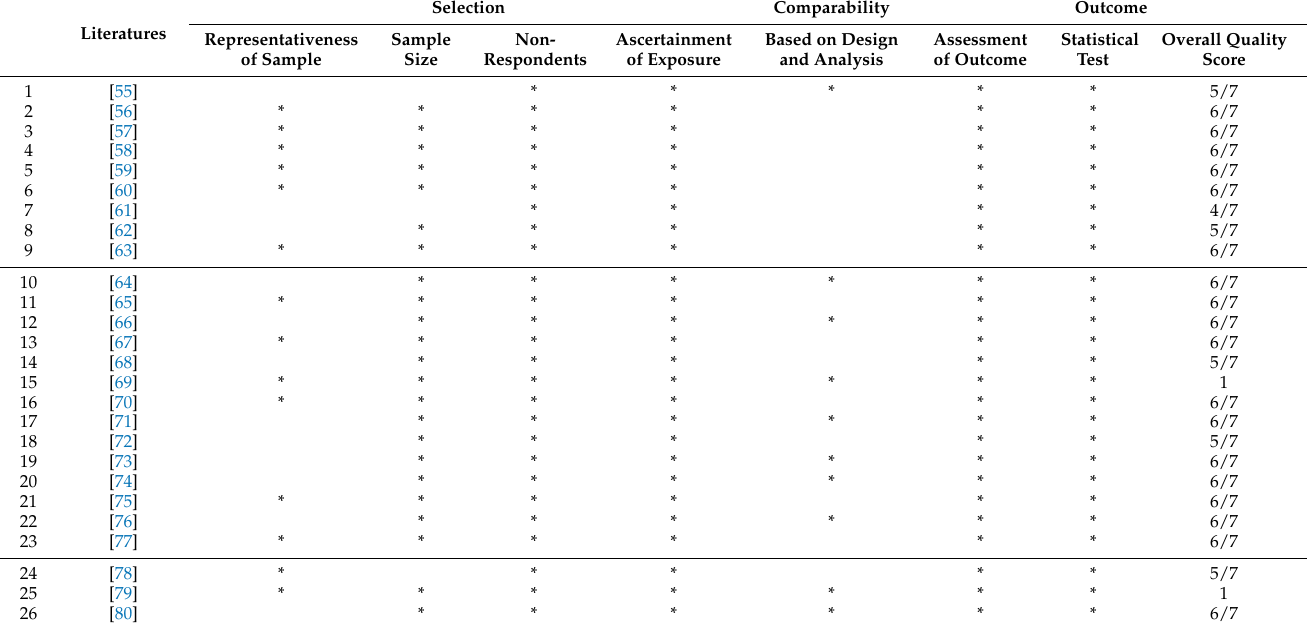
Table 1. Results of the critical appraisal of cross-sectional and longitudinal studies.